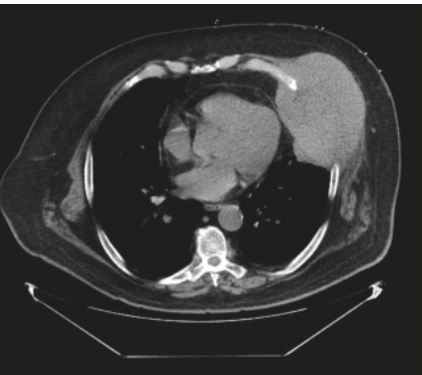
Figure 1: CT of chest with contrast showing 10 × 13 cm soft tissue mass in the left anterior lower hemithorax, from the left anterior 6th rib to the EO muscle and left pericardium, inseparable from LV myocardium.